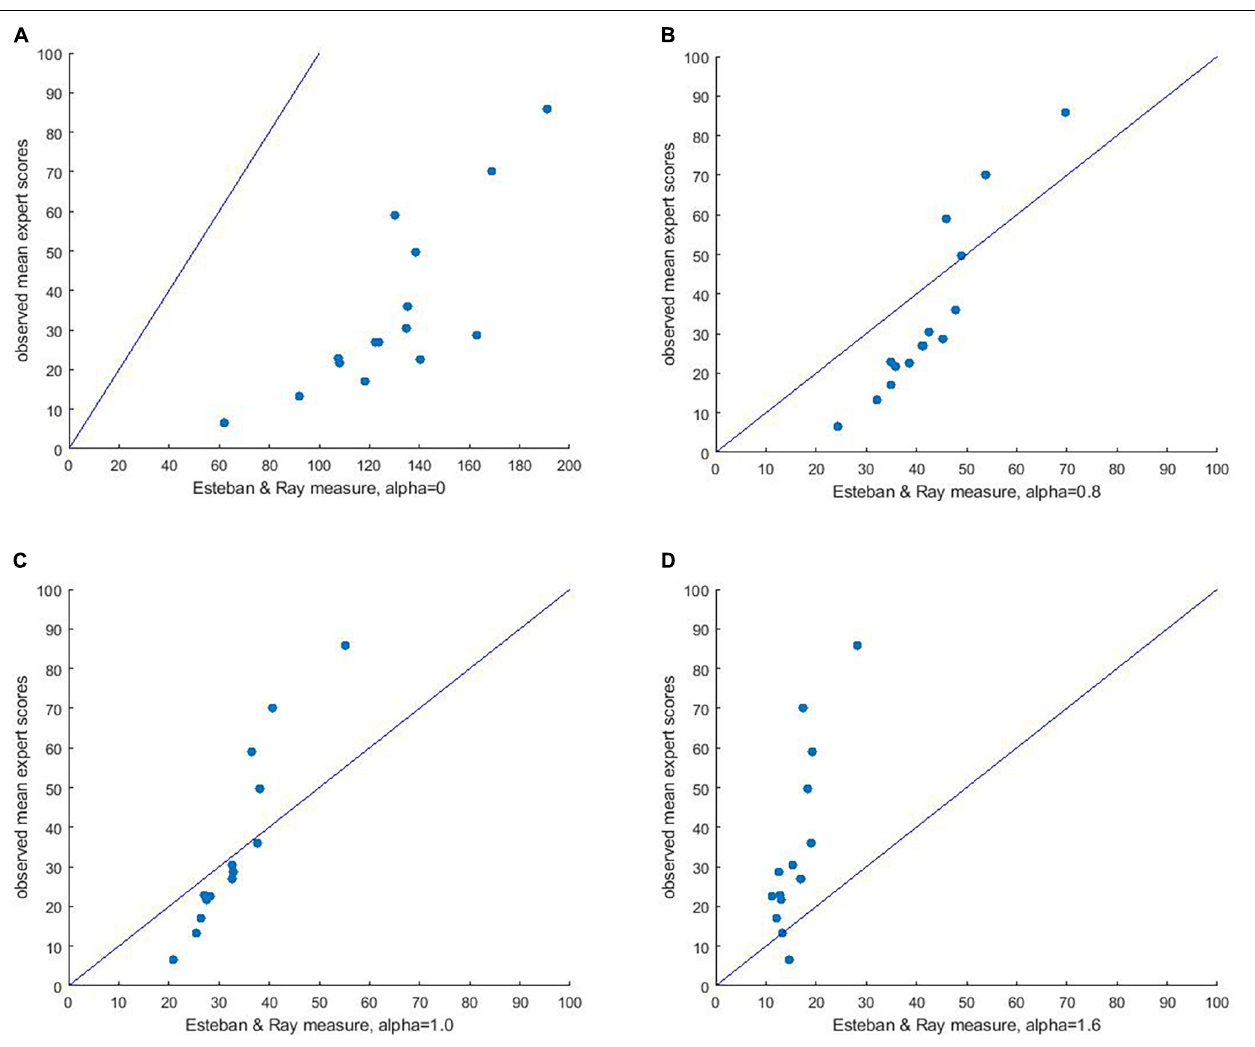
FIGURE 3 | Plot of mean expert polarization scores for all 15 distributions against Esteban & Ray’s polarization index, with alpha = 0 (A) , 0.8 (B) , 1 (C) , and 1.6 (D) .